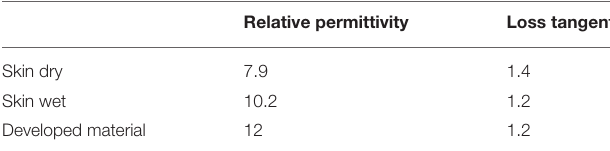
TABLE 2 | Dielectric properties of skin tissues